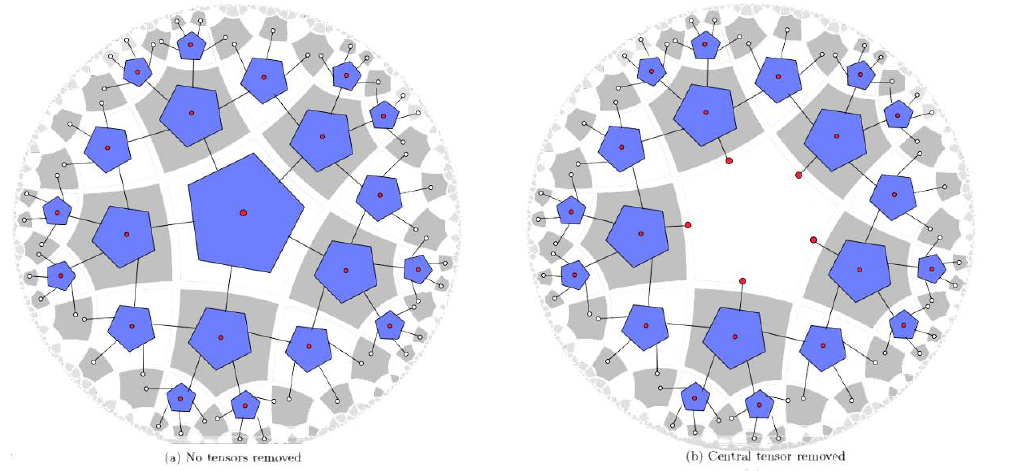
Figure 2 . (a) The pentagon code from [3]. Red dots indicate bulk (logical) indices, white dots indicate boundary (physical) indices. (b) The pentagon code from [3] with the central tensor removed. The indices from neighbouring tensors which were contracted with the central tensor are now logical